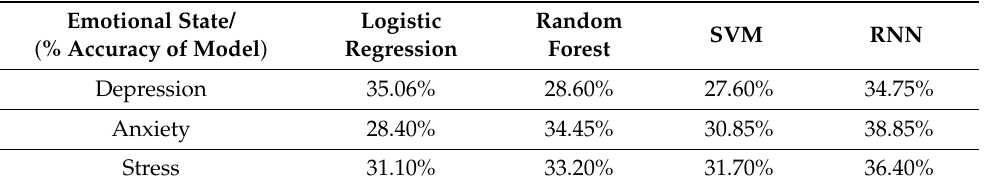
Table 3. Classifying Emotional States from the DASS 21